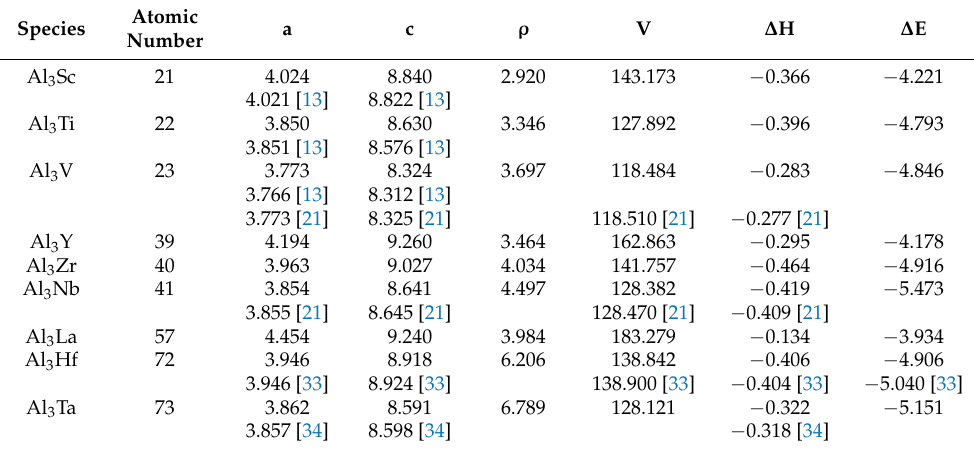
Table 1. The calculated lattice constant (a, c in Å), density ( ρ , g/cm 3 ), volume (Å 3 ), ∆ Hr (eV/atom) and Ecoh (eV/atom) of the Al 3 TM